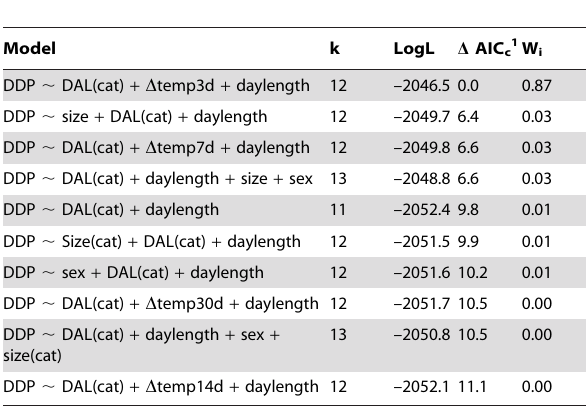
Table 2. Ten best supported models from the 72 a priori models relating environmental and individual covariates to daily detection probability (DDP) of lemon sharks at Cape